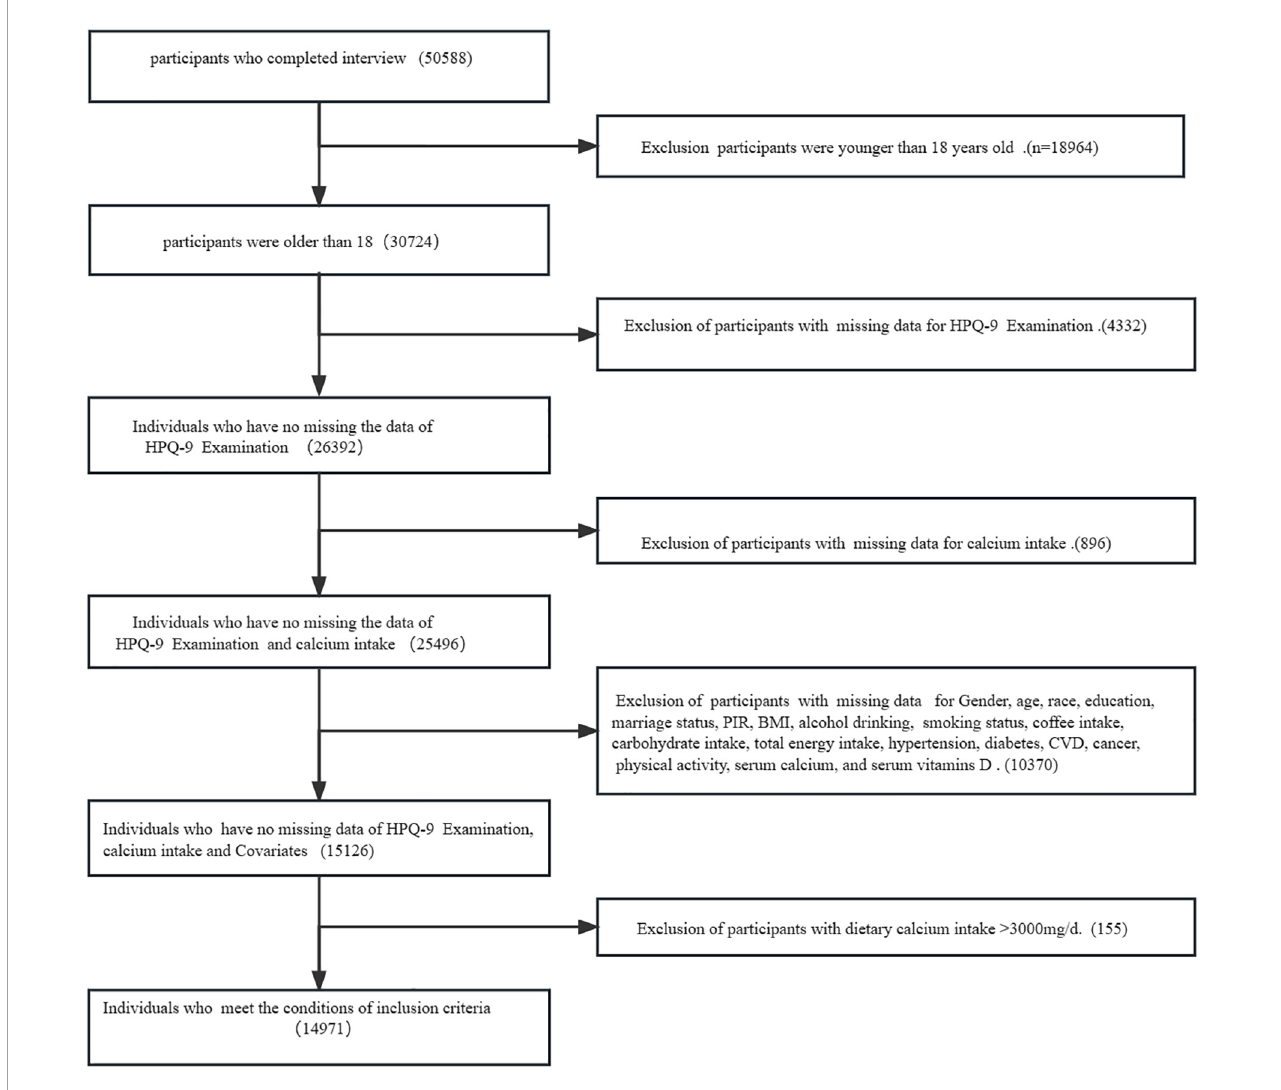
FIGURE1 The flow chart of inclusion and exclusion of the participants in the